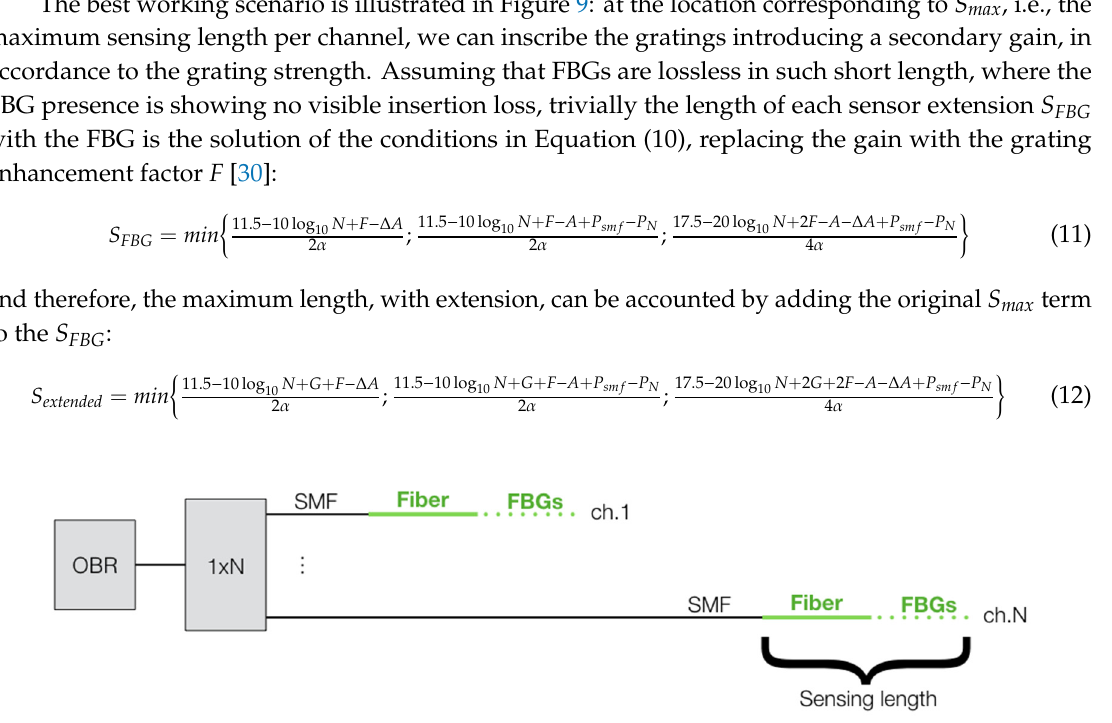
Figure 9. Sketch of the range-extended operation of SLMux through Fiber Bragg Gratings (FBGs).